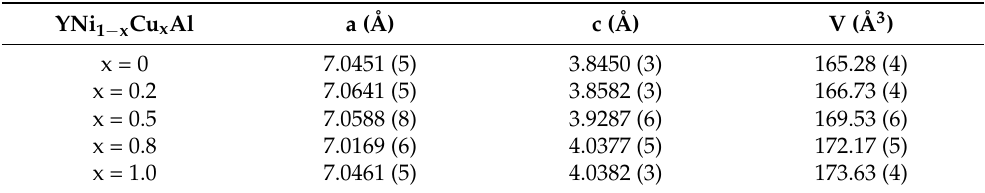
Table 2. Lattice parameters (a, c) and volume (V) as calculated by Rietveld refinements of the X-ray diffraction data of the YNi 1 − x Cu x Al series of alloys.